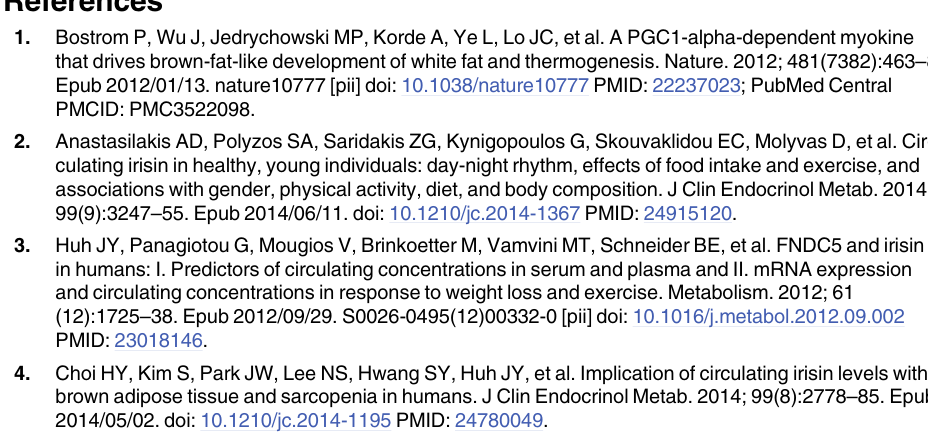
S1 Table. Individual numerical data for Irisin, age, BMI, body fat, waist circumference, fasting glucose, fasting insulin, HOMA-IR HOMA- β , quantitative insulin sensitivity